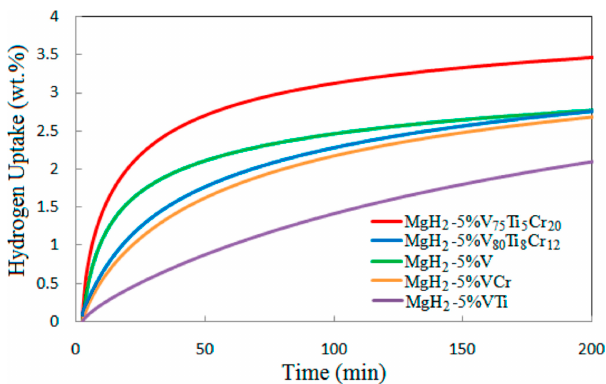
Figure 6. PCT (Pressure-Composition-Temperature) hydrogenation kinetics of MgH 2 with V 75 Ti 5 Cr 20 , V 80 Ti 8 Cr 12 , V, VCr, and VTi additives at the room temperature and 1 bar hydrogen pressure [186]. Another fast-developing intermetallic compound is the Zr-based alloy. 10% ZrNi-MgH 2 (mass fraction) completed 5% hydrogen absorption at 300 °C within 3 min and it took only 7 min to release the same amount of hydrogen, which suggested the excellent catalytic effect of Zr-based intermetallic compounds [187]. Makihara et al. [188] reported that Mg-50wt%ZrMn 2 completed 2.6% hydrogen absorption at 275 °C , while maximum hydrogen capacity of Mg-50wt%ZrFe 1.4 Cr 0.5 was 3.2% at 300 °C and hydrogen desorption was completed at 0.1 MPa within 15 min [189]. Wang et al. [190] prepared Mg x /Mg 2 Ni ( x = 10%, 30%, 50%) composite alloys by mixing and ball milling of the powder of Mg 2 Ni alloys and magnesium. In contrast to the fact that with separate ball milling of Mg 2 Ni alloys Mg 2 Ni are decomposed into Mg and Ni, these mixed powders do not form new phases during ball milling due to the effective inhibition of decomposition of the Mg 2 Ni phase by adding magnesium powder. The intermetallic alloys have even more pronounced catalytic effects. It is not clear at present time, however, why the intermetallic alloys would have more significant effects than their elemental counter parts. One observation is that these alloys form less stable hydrides than their corresponding elemental metals. Details of the investigation results of the part of the above selected works on modification using intermetallic compound additives are presented in Table 6. Table 6. Hydrogen storage properties of selected Mg modified by intermetallic compounds. Material